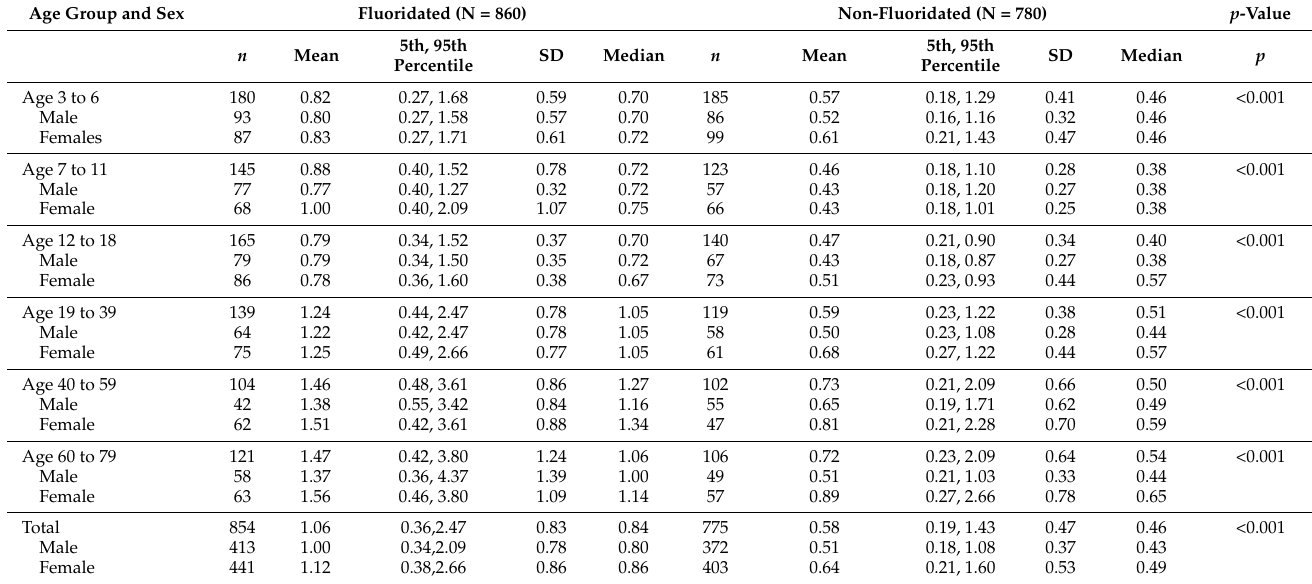
Table 1. UF SG (mg/L) by sex, age group, and CWF status, with t -tests comparing UF SG for individuals living in fluoridated and non-fluoridated regions by age